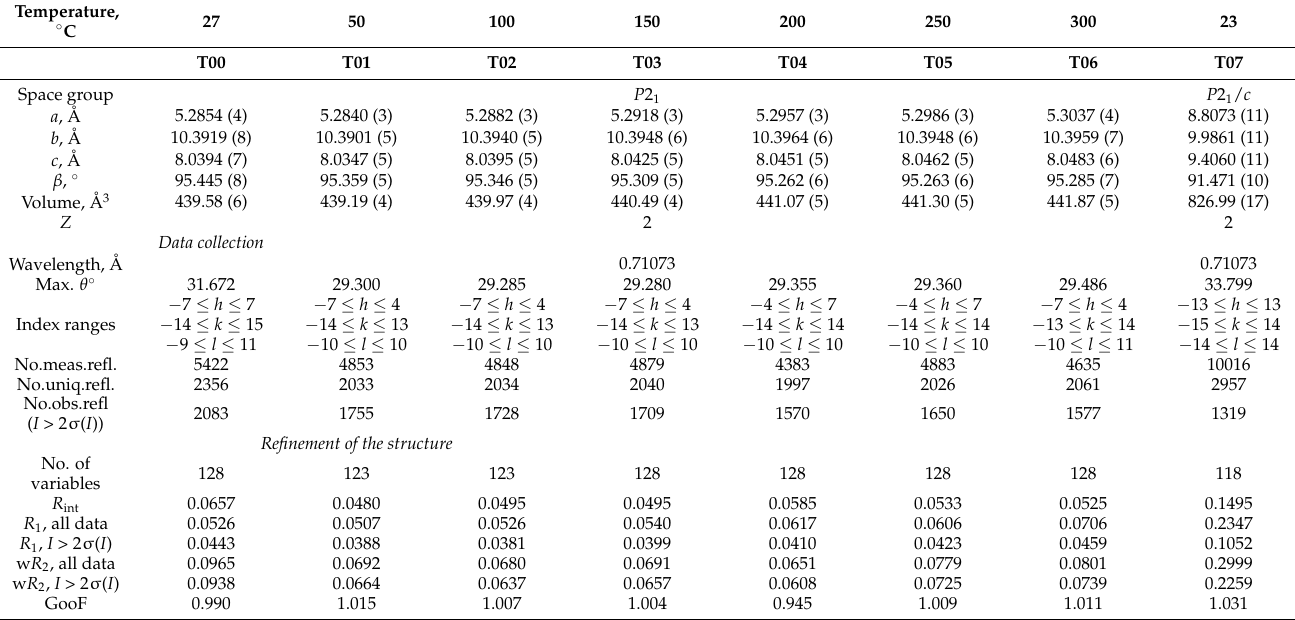
Table 1. Crystallographic data and refinement parameters for BaZn 2 As 2 O 8 · H 2 O at different tempera- tures and BaZn 2 As 2 O 8 at room temperature